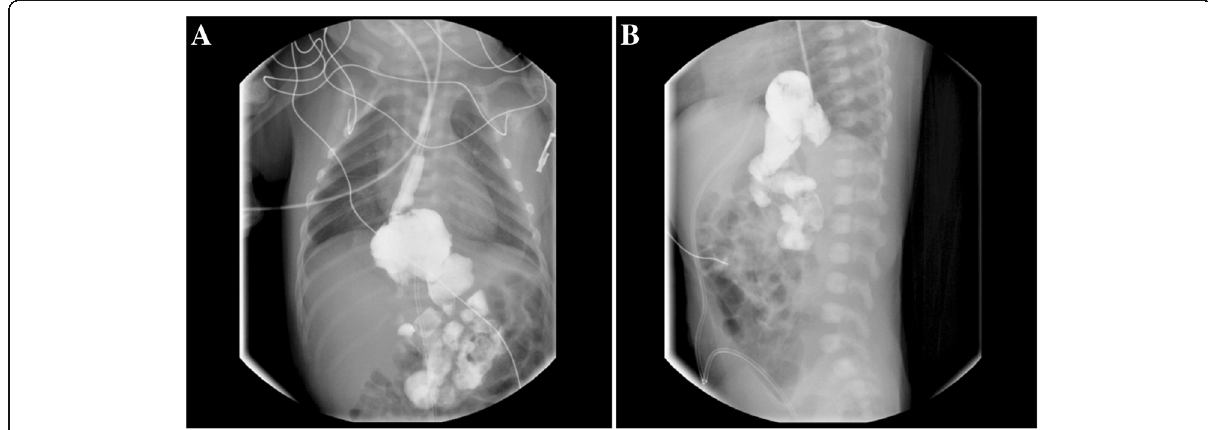
Fig. 1 Upper gastrointestinal examination of Case II-1. Anteroposterior ( a ) and lateral ( b ) projections revealed an upward dislocation of the stomach into the mediastinum, which is compatible with a hiatal